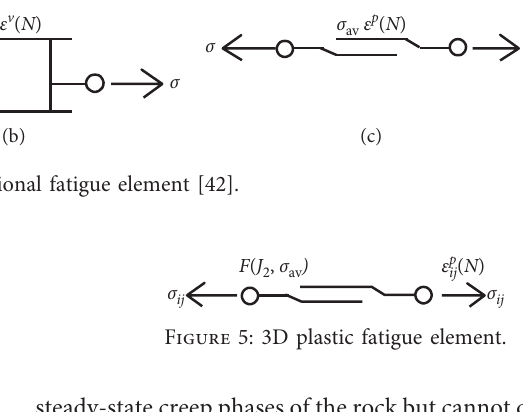
Figure 5: 3D plastic fatigue